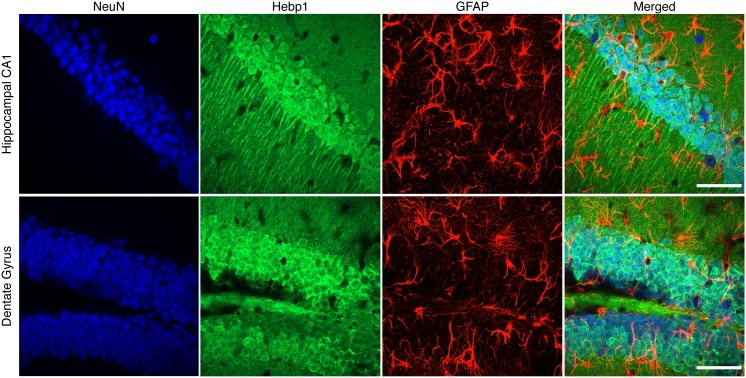
Expression of Hebp1 is localized to neurons.High magnification views of the hippocampus and dentate gyrus brain regions stained with Hebp1, NeuN and GFAP. Hebp1 staining coincides with NeuN but not GFAP. Scale bar is 50 µm.